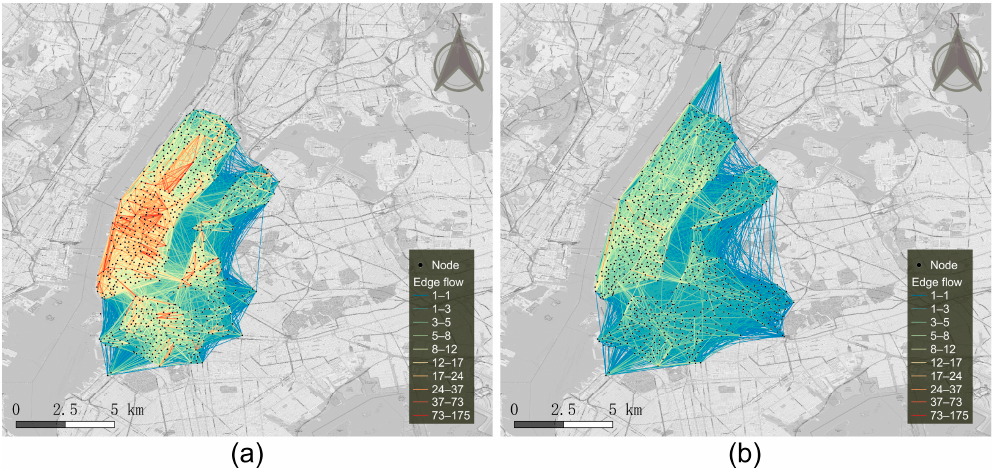
Figure 9. Bike-sharing networks of the first four Wednesdays in ( a ) 2019 and ( b ) 2020.